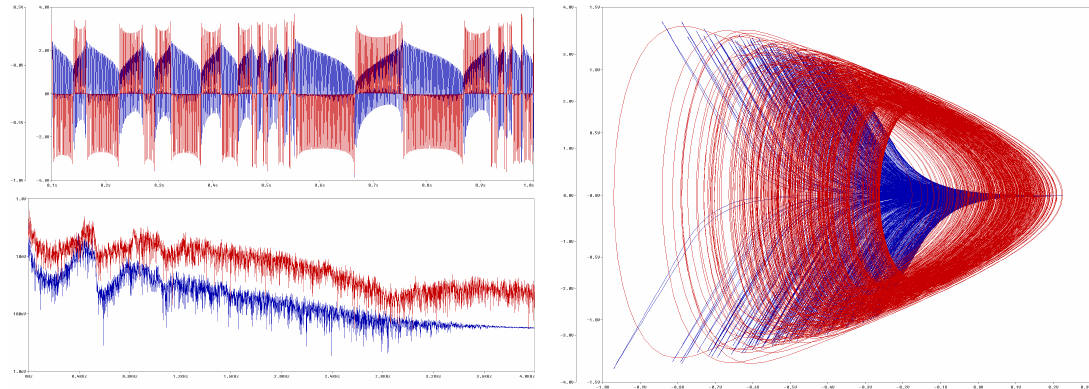
Figure 11. Simulation of the current-mode chaotic oscillator using professional macro-models of AD844, EL2082 and EL4083: signal x and − z in time domain (upper left graph); same waveforms in the frequency domain (lower left picture); plane projections of the chaotic attractor in xy (blue) and xz plane (red).